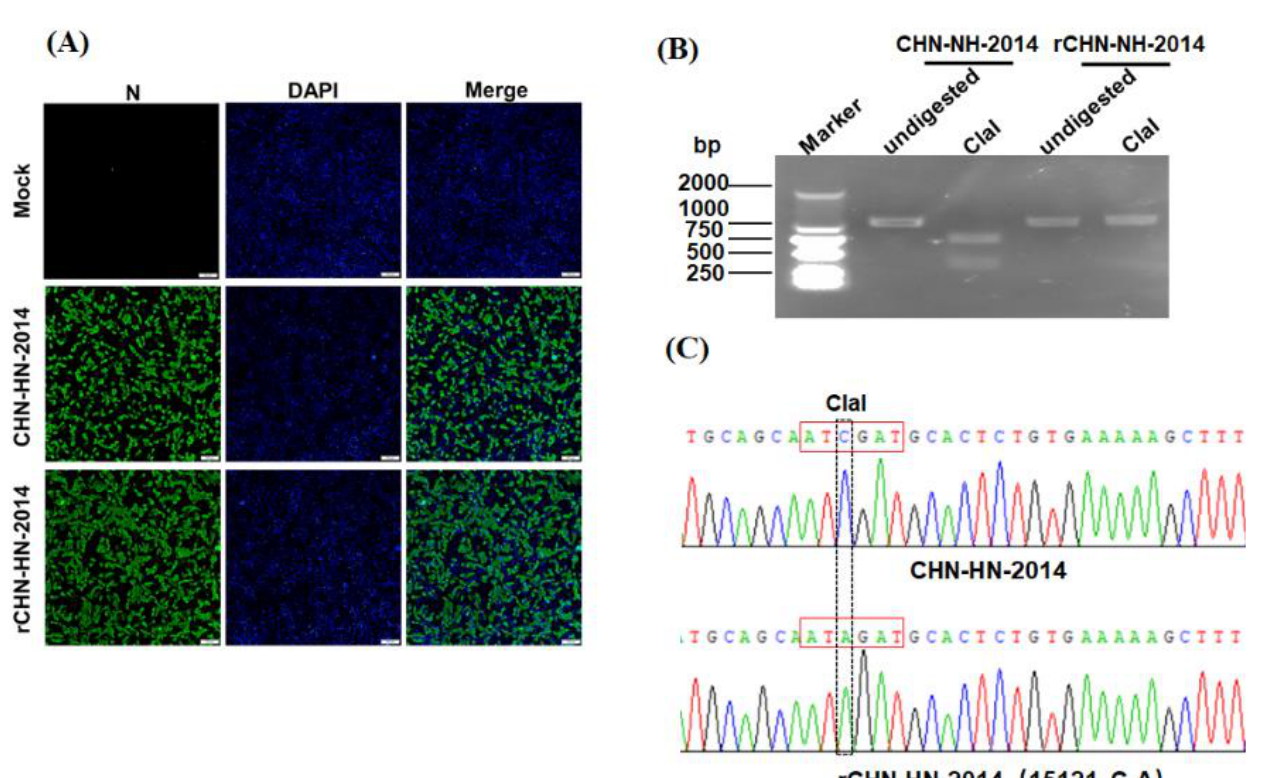
Figure 2. Identification of the rescued PDCoV, rCHN-HN-2014. ( A ) Indirect immunofluorescence analysis of LLC-PK1 cells infected with rCHN-HN-2014 and CHN-HN-2014 at 12 hpi using anti-PDCoV N monoclonal antibody. Bar, 100 μm. ( B ) Differentiation between rCHN-HN-2014 and CHN-HN-2014. The presence of a ClaI restriction site resulted in fragments of 364 bp and 716 bp after digestion with this enzyme. As expected, the restriction site was found in CHN-HN-2014 but not in the rCHN-HN-2014. ( C ) Identification of the introduced molecular marker (15121C → A) in the rCHN-HN-2014 via DNA sequencing. The dotted and red frame represent the molecular marker site and the recognition sequence by ClaI restriction enzymes, respectively.